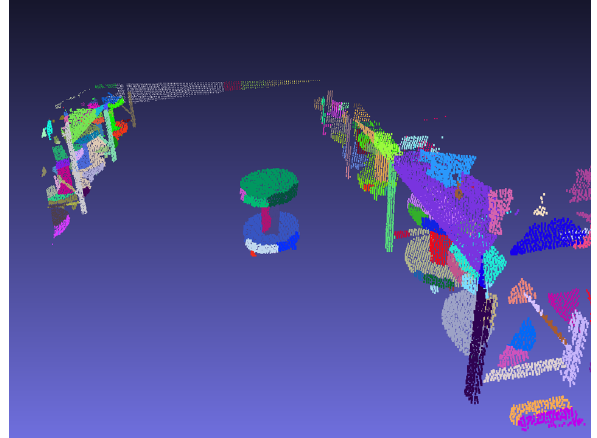
Figure 2. Result of over-segmentation for generating local object patches before applying min-cut optimization to final object